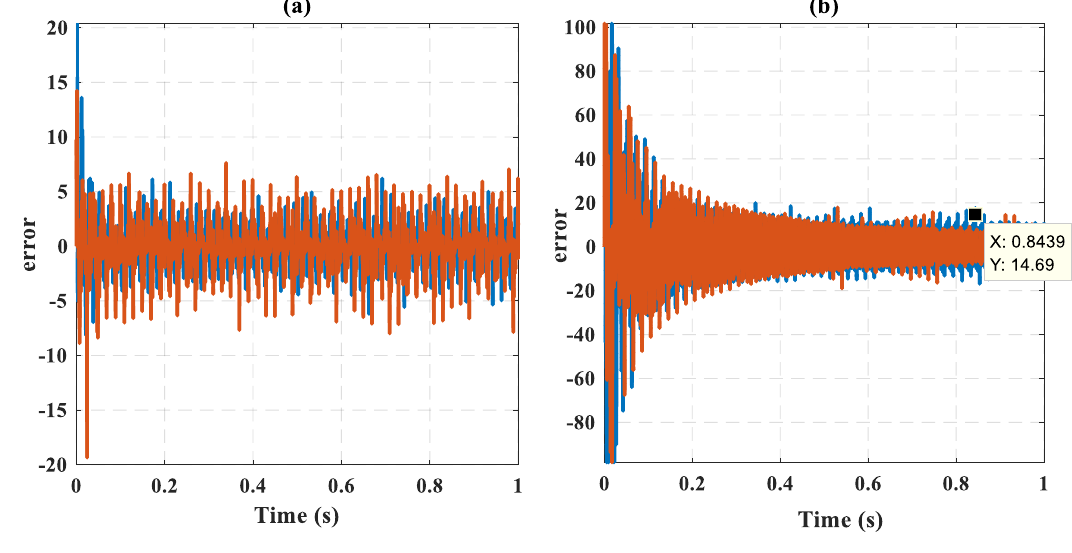
Figure 10. Error signal of output current; ( a ) SMC; ( b ) PR.